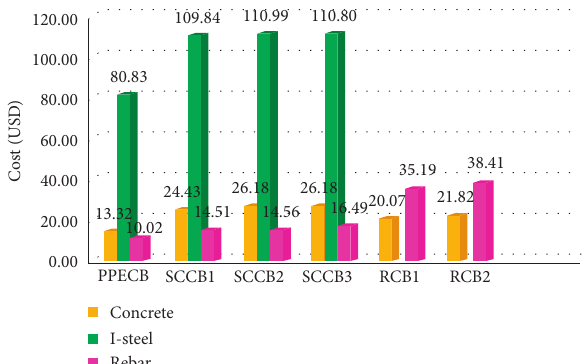
Figure 11: The cost of material for different beams.